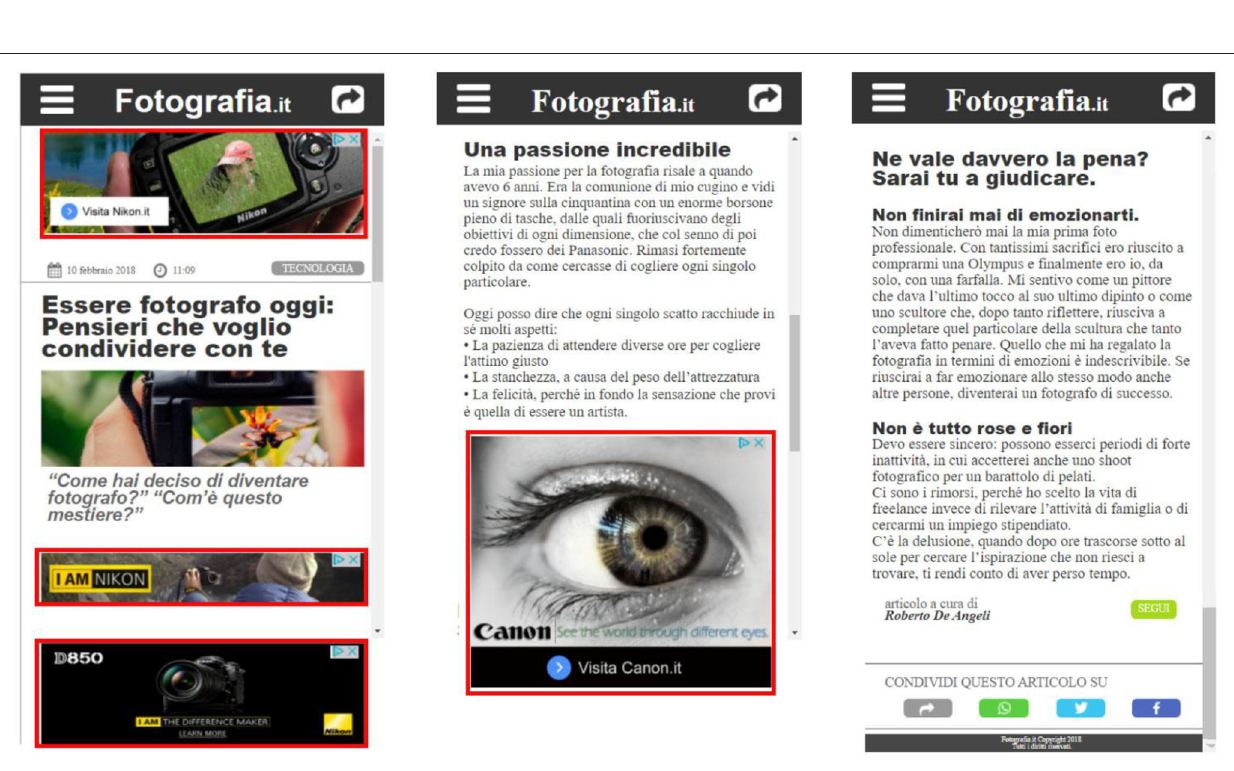
FIGURE 3 | Areas of interest (AOIs)/eye-tracking: the figure shows a sample article where the AOIs, associated with the advertising spaces, are highlighted in red. The third ad, placed in a bottom fixed position, was always visible while scrolling. The AOIs position and dimension were the same for both article formats (display and